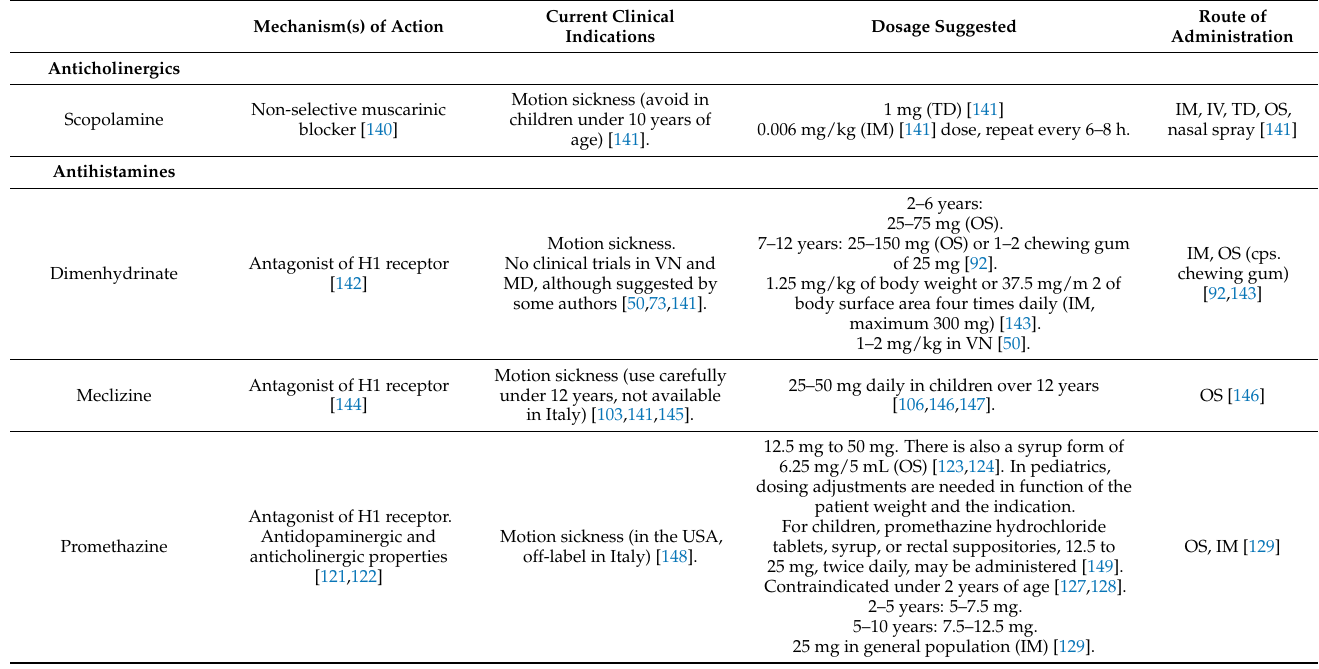
Table 5. Rationale, current clinical indications, and dosages of peripheral vestibular vertigo drugs in children (indication to